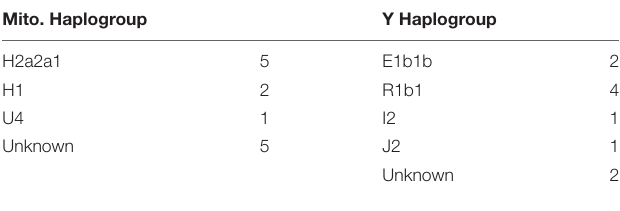
TABLE 1 | Inferred mitochondrial and Y chromosome haplogroups of founding individuals, and the number of occurrences of each group. Mito. Haplogroup